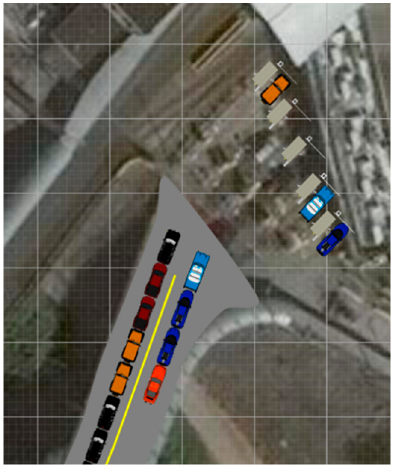
Figure 2. GIB POE in SIMIO